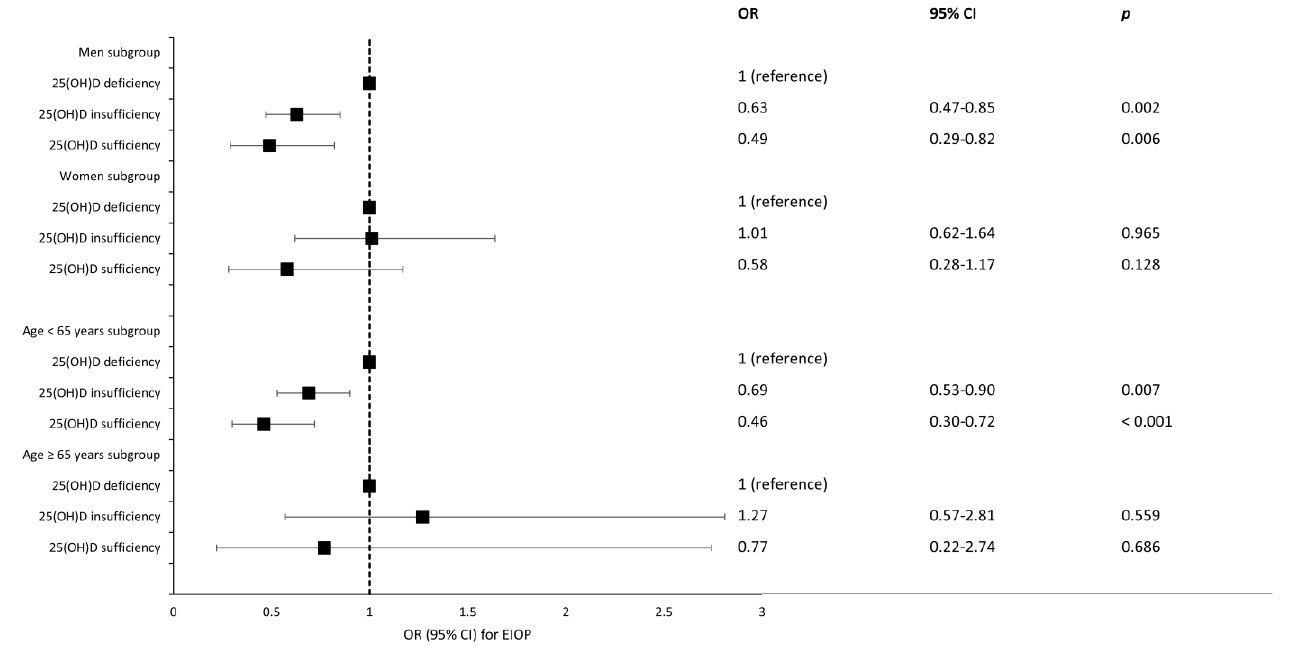
Figure 4. Forest plot showing the relationship between 25(OH)D status and EIOP in the sex subgroup and age subgroup. p -value < 0.05 considered as statistical significance. Abbreviation: 25(OH)D, 25-hydroxyvitamin D; EIOP, elevated intraocular pressure; OR, odds ratio; CI, confidence